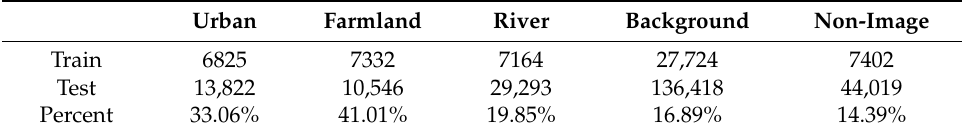
Table 2. The numbers of superpixels of diverse classes in the training and testing set. Urban Farmland